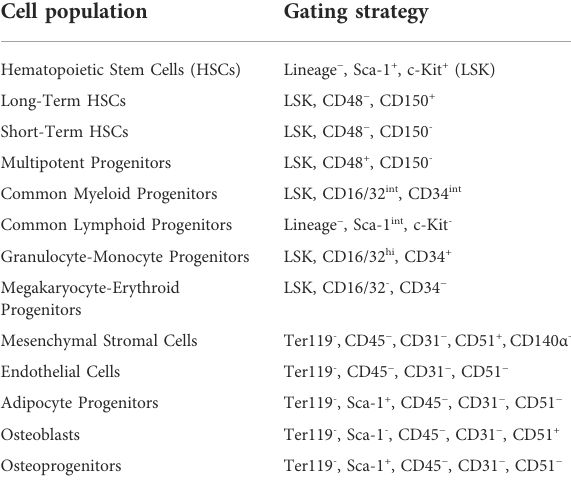
TABLE 1 Flow cytometry gating strategies for HSPC and niche cell populations. Cell population